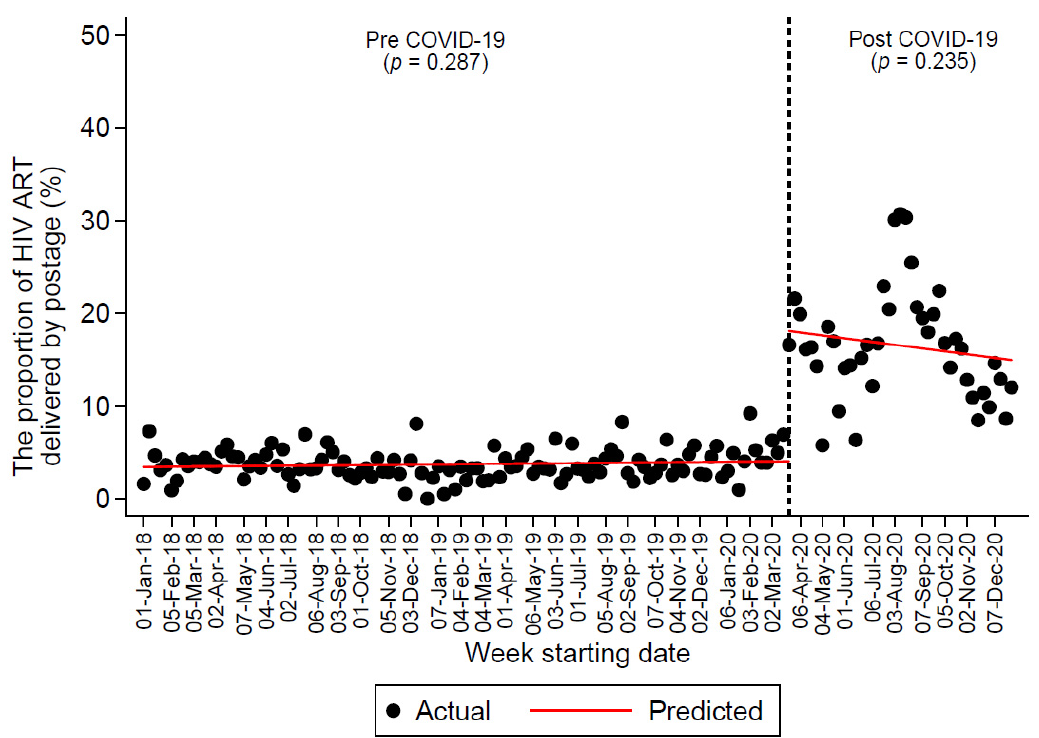
Figure 1. Segmented linear regression analysis of the proportion of HIV ART delivered by postage before and during the COVID-19 pandemic (indicated by the dotted line).